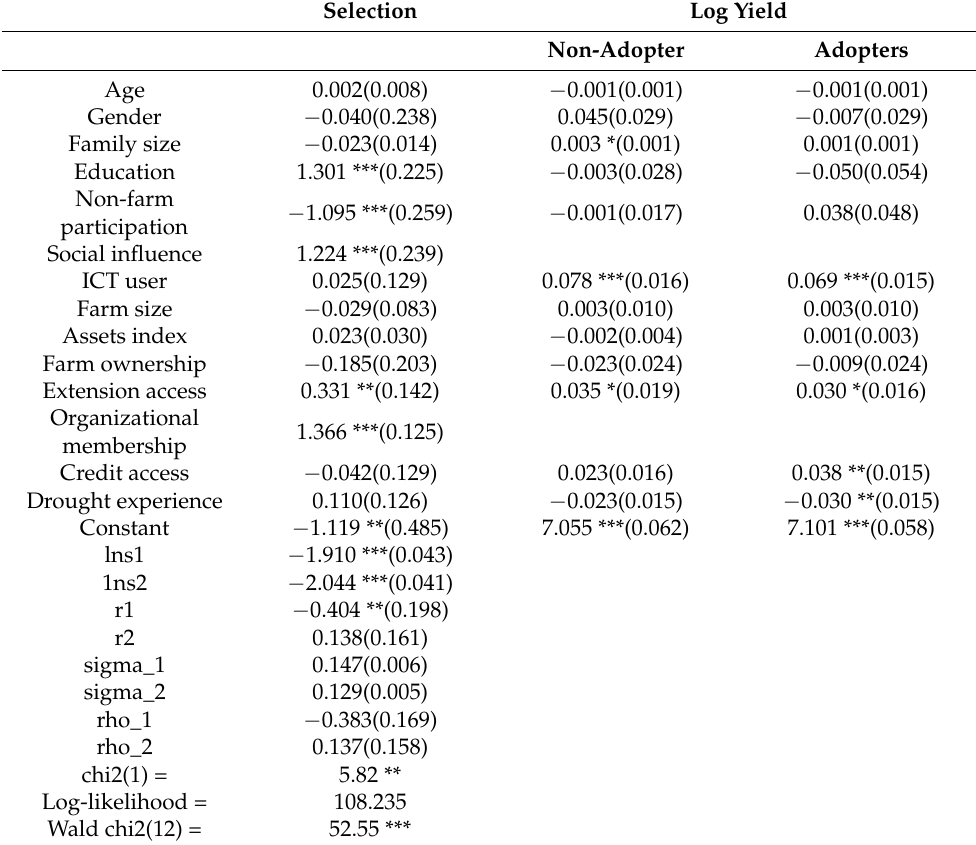
Table 2. Full information maximum likelihood (FIML) of ESRM